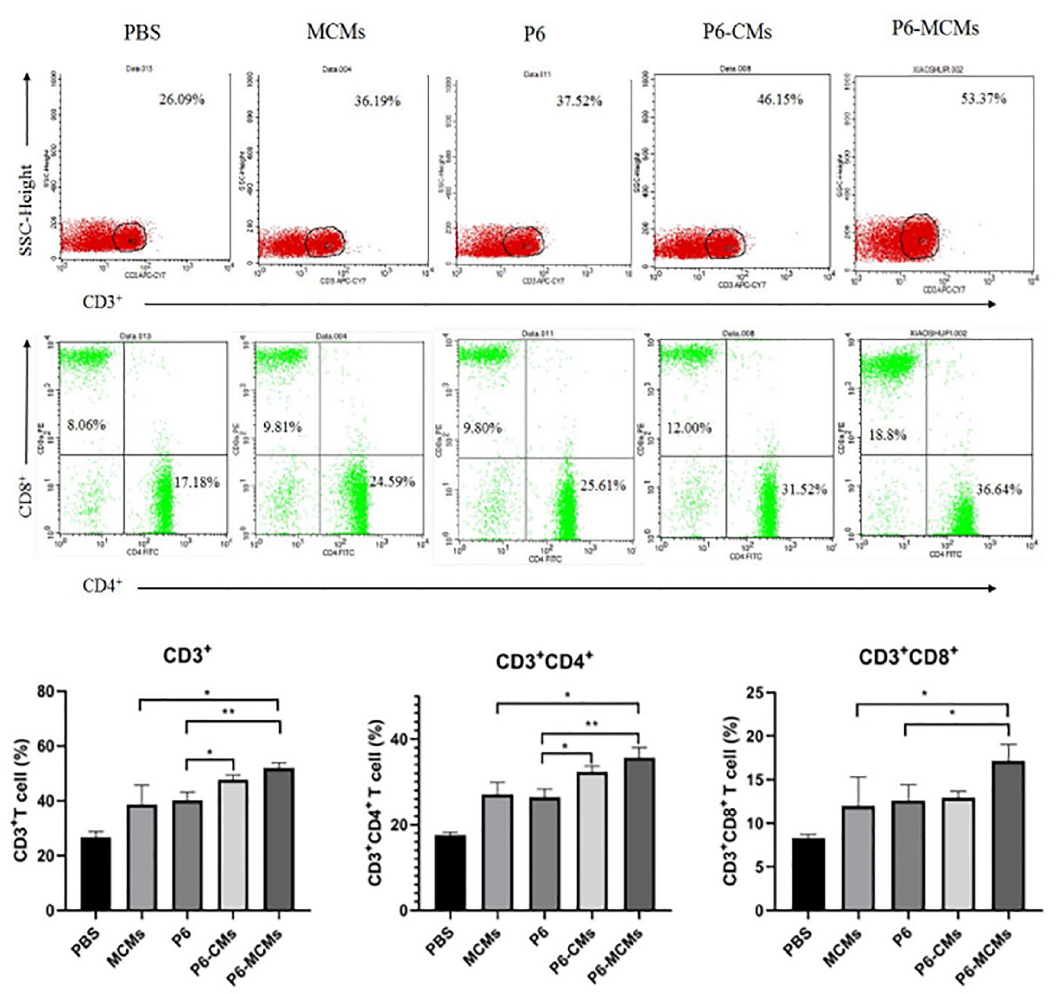
Fig 6. Flow cytometric analysis of spleen T lymphocyte subsets in different groups of immunized mice. A “Three-Color, Dual Anchor” gating strategy to identify the lymphocyte subsets (CD3 + , CD4 + and CD8 + ); the proportions are shown. Values are expressed as a percentage. Cells were stained with APC-Cy ™ 7 Rat Anti-Mouse CD3, FITC Rat Anti-Mouse CD4 and PE Rat Anti- Mouse CD8a. B Comparison of CD3 + T cell proportions in spleen lymphocytes. C Comparison of CD3 + CD4 + T cell proportions in spleen lymphocytes. D Comparison of CD3 + CD8 + T cell proportions in spleen lymphocytes. Mean ± SD, n = 3. � P < 0.05, �� P < 0.01.